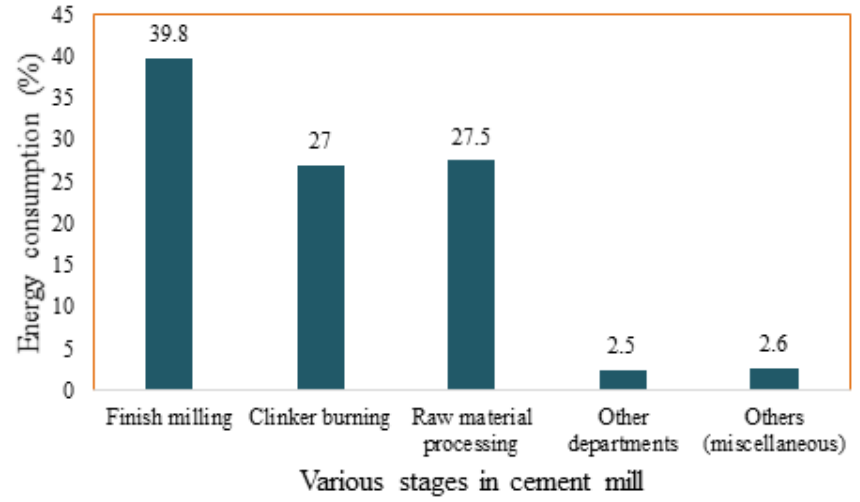
Figure 1. Percentage of energy consumption in the cement manufacturing sector.